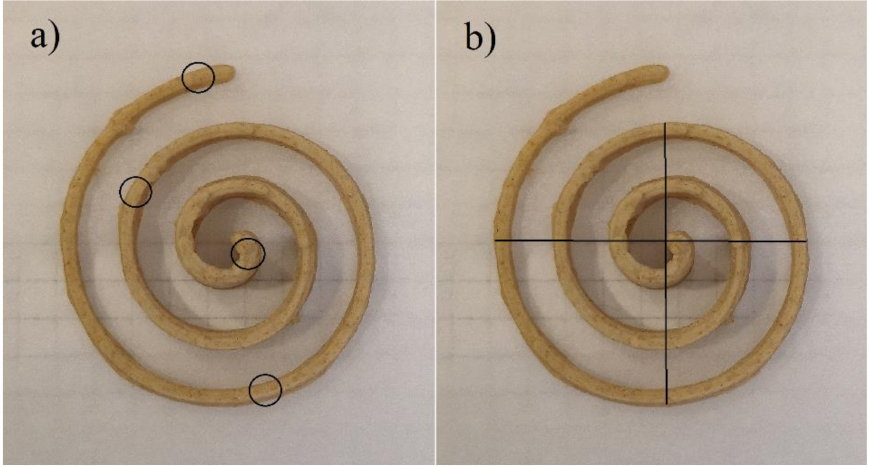
Figure 2. Measuring positions of: ( a ) snack height and line width; ( b ) diameter of baked snacks. All samples were scanned at 600 dpi (CanoScan, LIDE 2020, Canon, Tokyo,